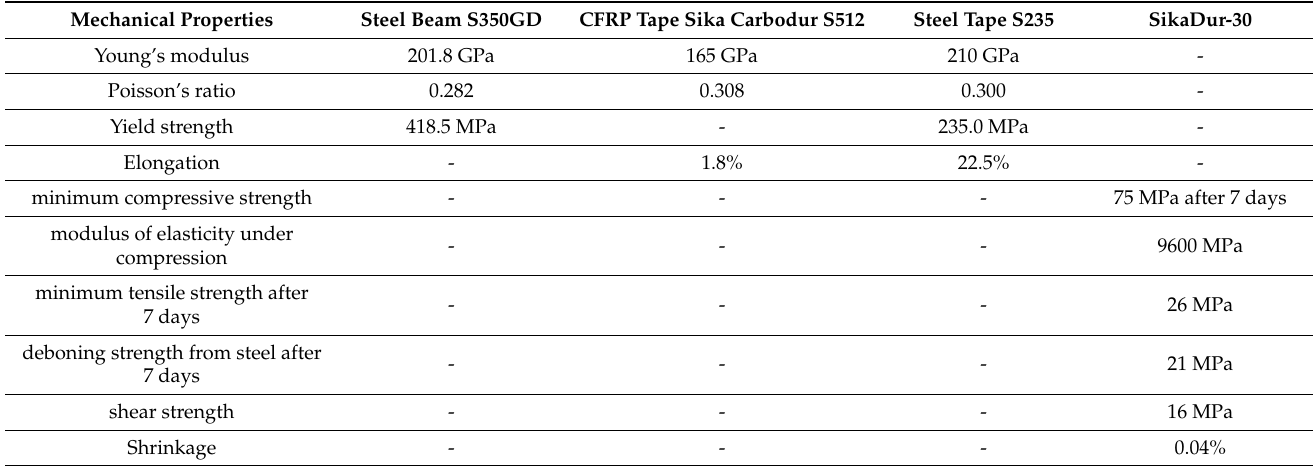
Figure 2. Scope of the tests: ( a ) reference beam, ( b ) CFRP tapes location and sample symbols, and ( c ) steel tapes location and sample symbols. SikaDur ® -30 glue (Sika Poland, Warsaw, Poland) with a thickness of 1.3 mm was used for each joint. The dimensions of the tapes cross-sections were similar for both tapes: materials used in the study are presented in Table 1. Table 1. Mechanical properties of tested elements materials.